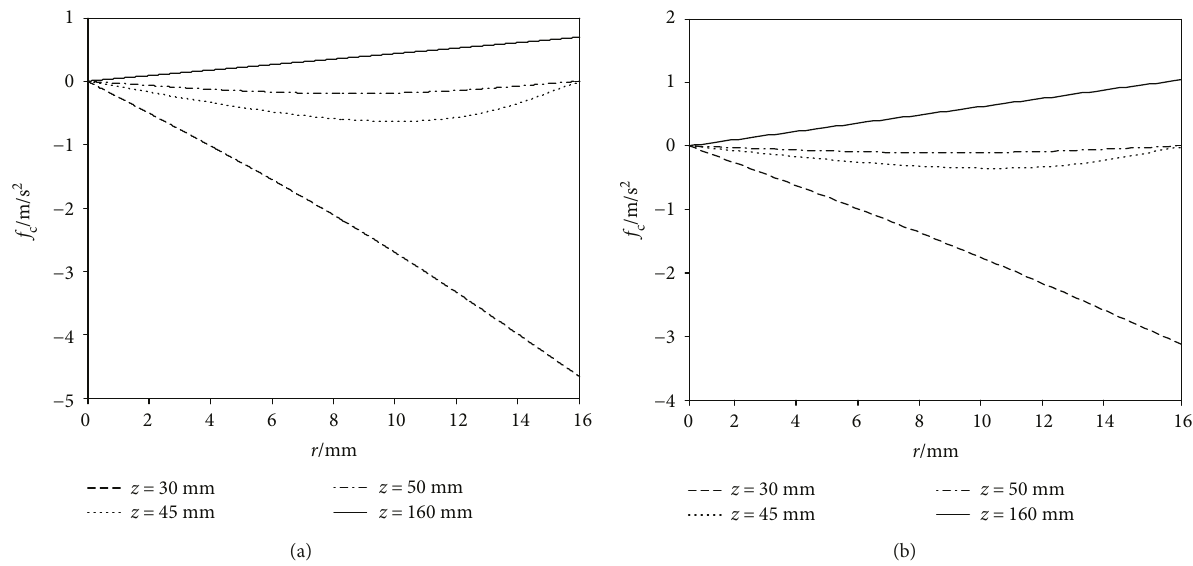
Figure 6: Distribution of the Coriolis force along the radial direction for di ff erent cases. (a) Distribution in vapor for case 2. (b) Distribution in vapor for case 3.